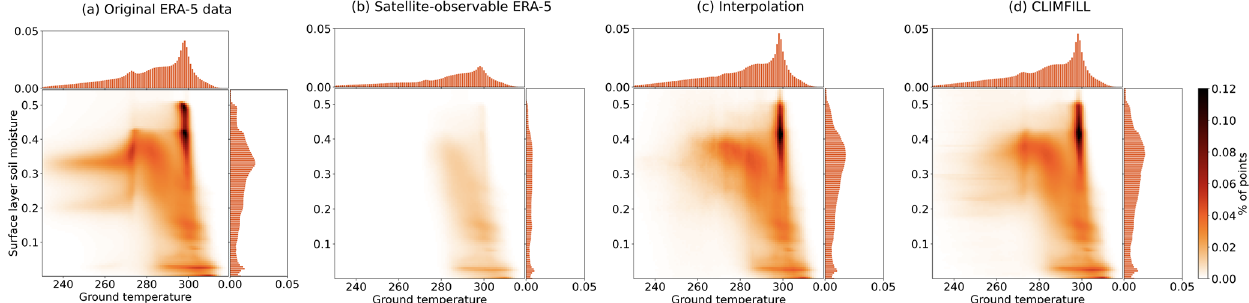
Figure 7. Bivariate and univariate histograms of surface-layer soil moisture and ground temperature in (a) the original ERA-5 data, (b) the subset of the original ERA-5 data that would have been observable by satellite, and (c) the data that has been gap filled via univariate interpolation and (d) via CLIMFILL gap filling. For bivariate distributions of other variable pairs, see Fig. A1 in Appendix A.